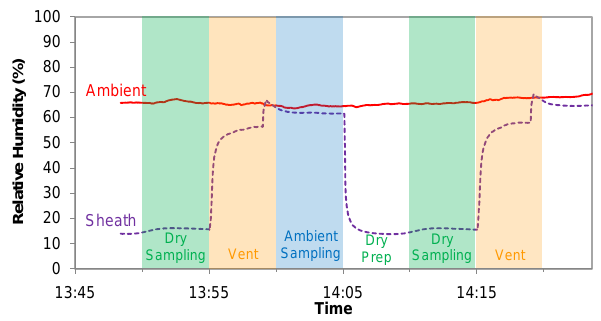
Fig. 2. Example of RH time series in DAASS for the various instru- ment modes.